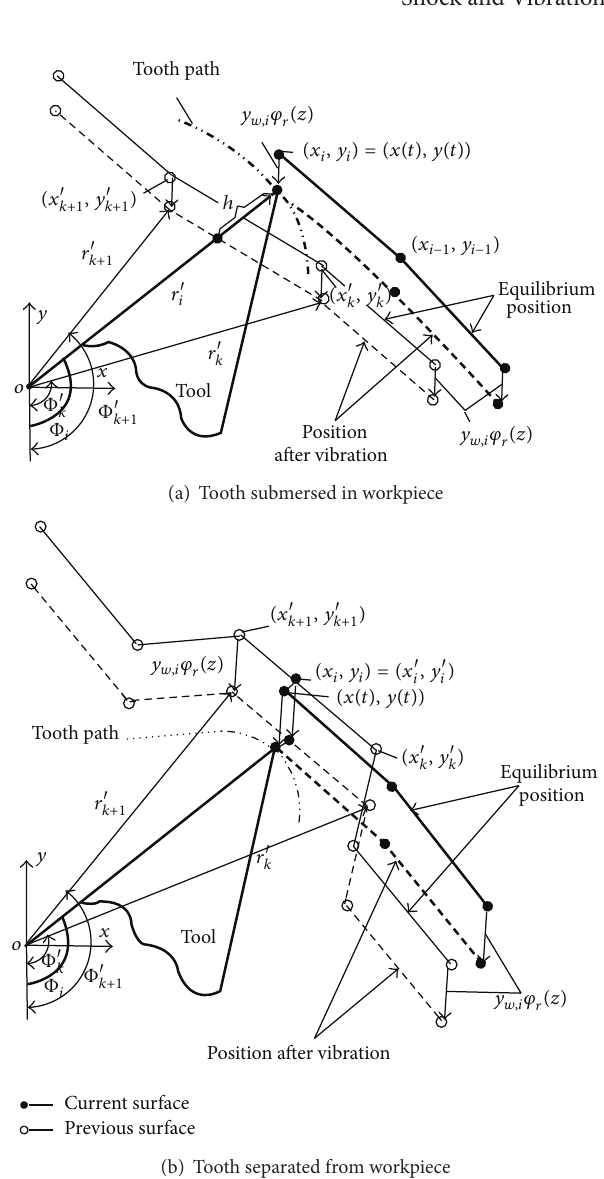
Figure 16: The geometrical relationship between tool and work-